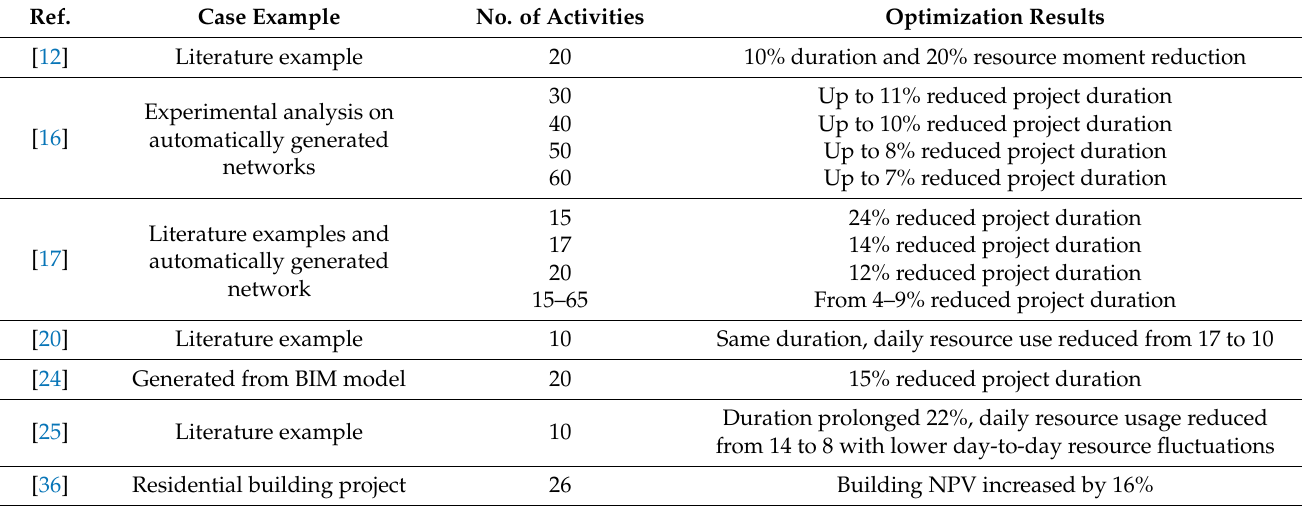
Table 4. Results of reviewed resource-oriented optimization